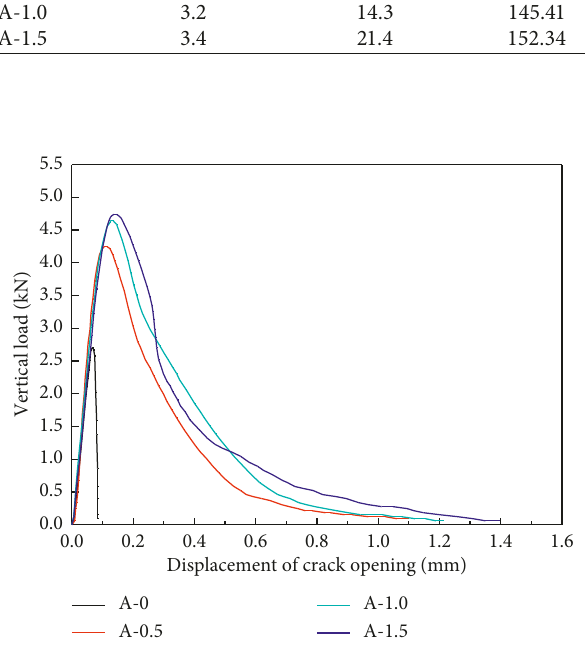
Figure 8: Relationship between vertical load and displacement of crack opening.